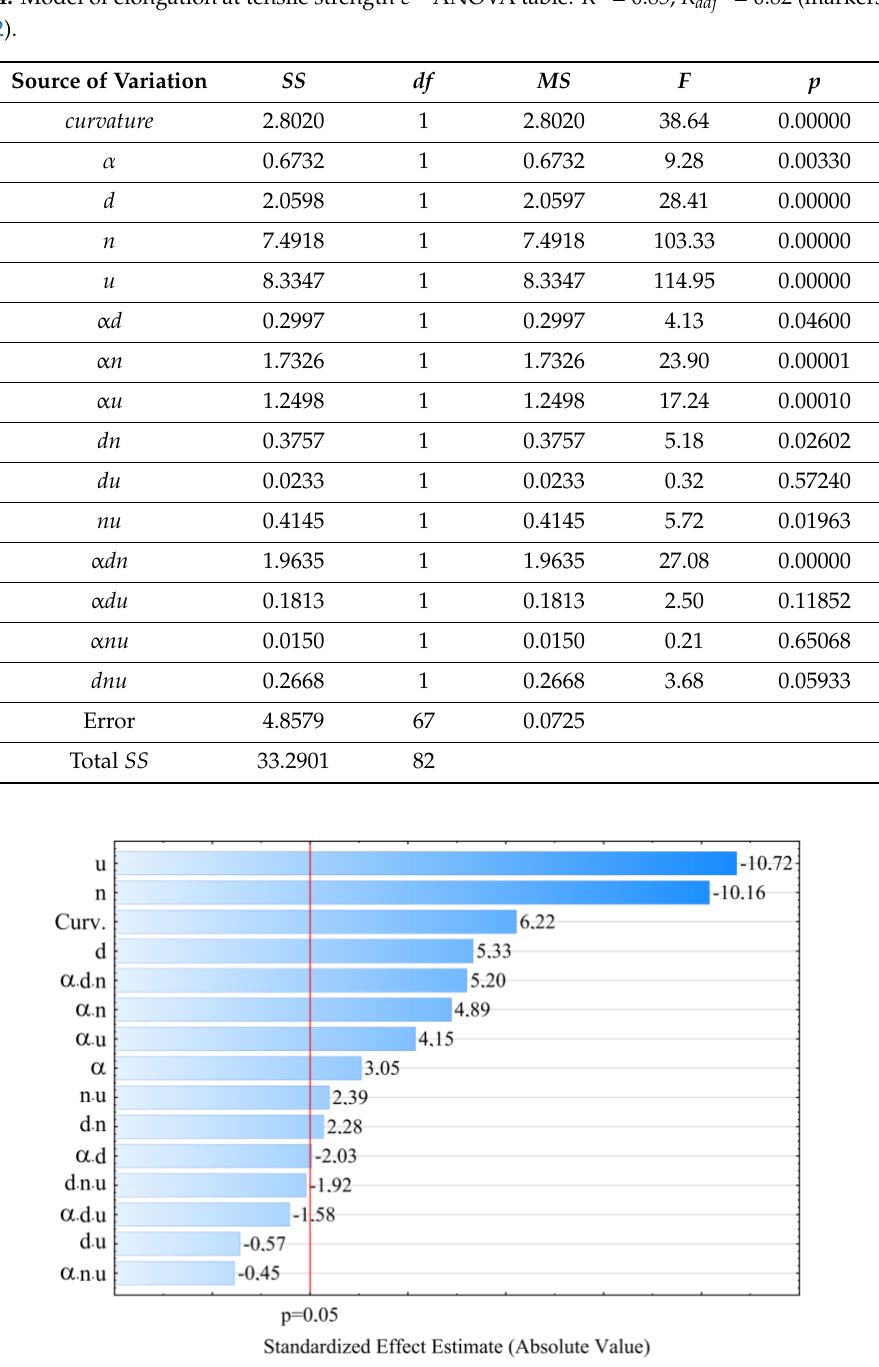
Figure 10. Pareto plots of the standardized e ff ects of empirical model of elongation at tensile strength ε , Figure 10 the vertical line in plot corresponds to the arbitrarily chosen level of significance (p =